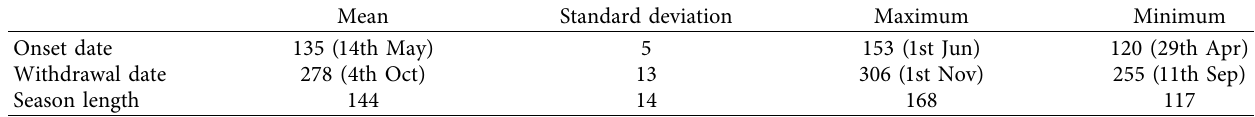
Table 4: CPI index results of large-scale MSwM onset, withdrawal, and season length.